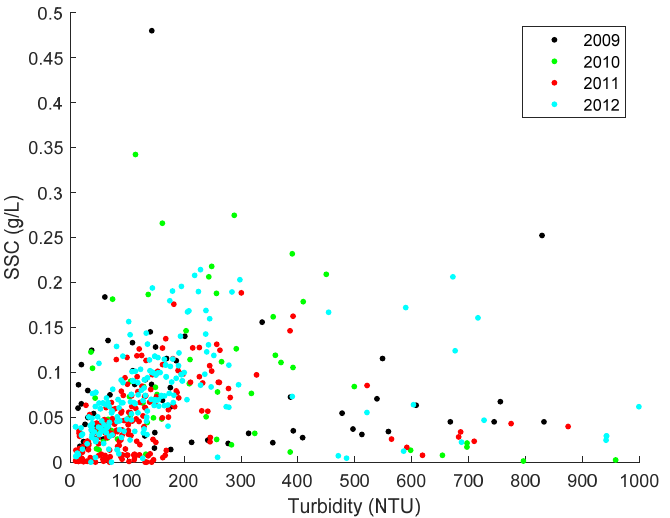
Figure A1. Scatterplot relating the suspended sediment concentration (SSC) and the turbidity.